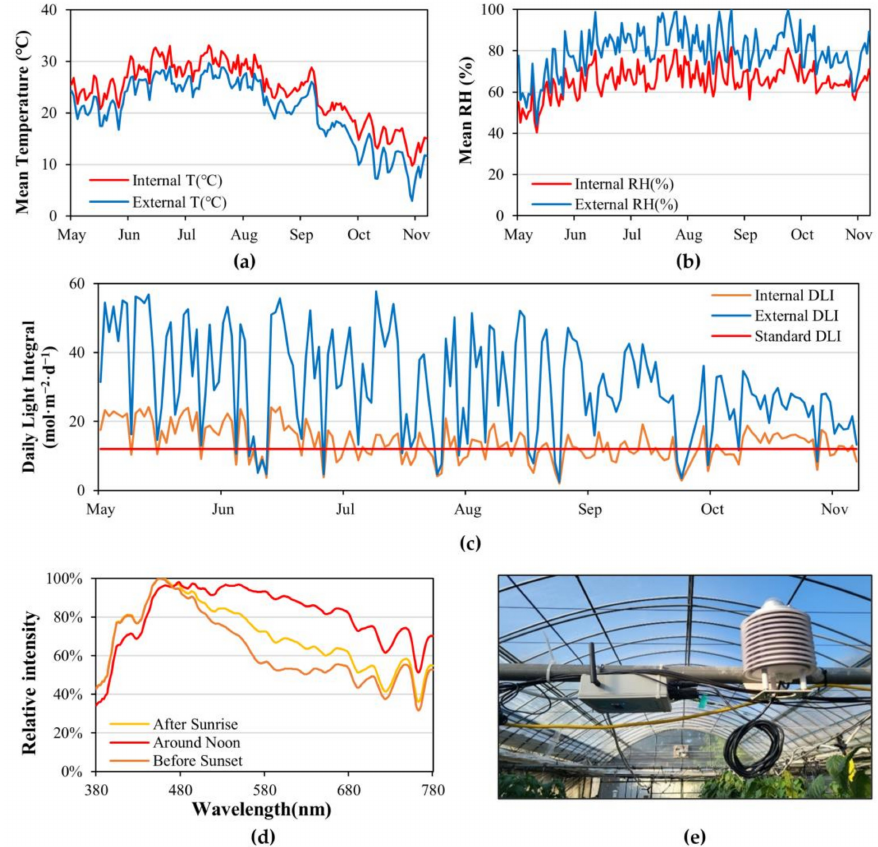
Figure 5. Changes in the greenhouse environment during the experimental period. ( a ) Mean tempera- ture ( ◦ C). ( b ) Mean relative humidity (%). ( c ) Daily light integral (mol · m − 2 · d − 1 ), where the standard DLI was based on the minimum DLI required for paprika. ( d ) Changes in solar spectrum over time: after sunrise (07:00~08:00), around noon (13:00~14:00), and before sunset (18:00~19:00). ( e ) Image of sensor measuring the greenhouse environment (iocrops